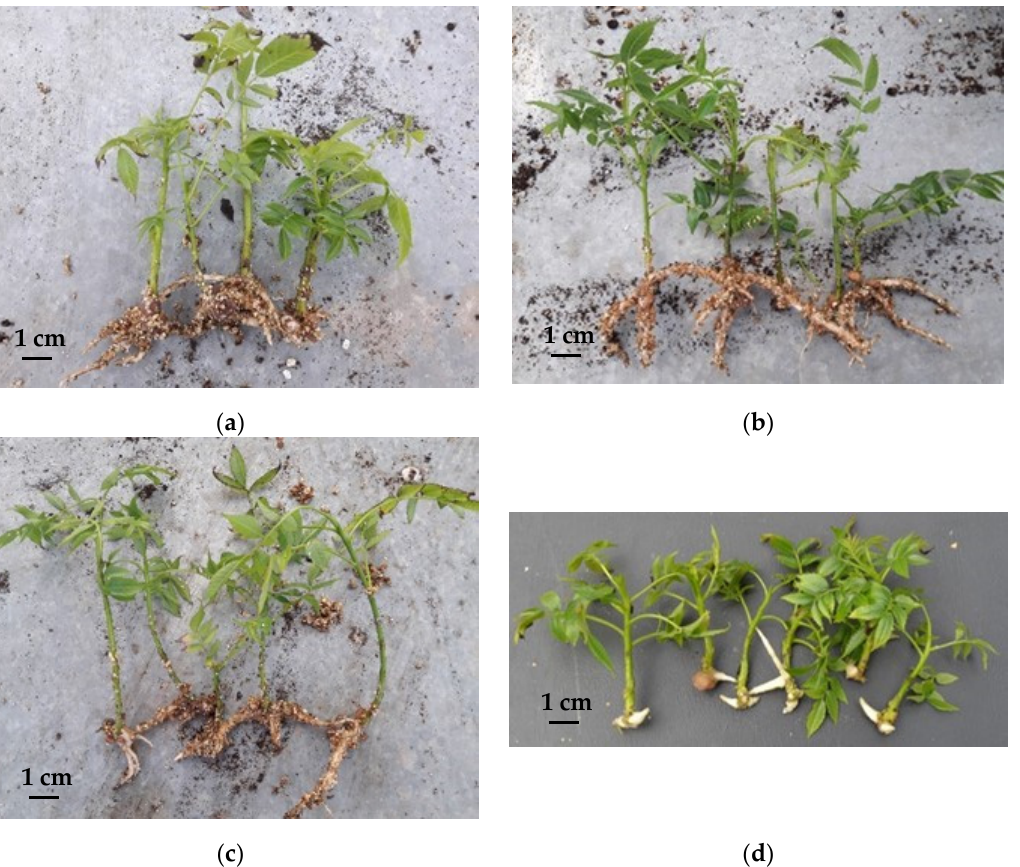
Figure 3. Root expression of a Mj209 × Ra clone in glass containers using: ( a – c ) stationary liquid media with vermiculite and ( d ) a temporary immersion system (TIS) using SETIS bioreactors. Microshoots obtained from cultures proliferated in: ( a , d ) gelled media, ( b ) TIS, using handmade temporary immersion bioreactors (TIB) and ( c ) Plantform bioreactors (Photos provided by R.J. Licea-Moreno).